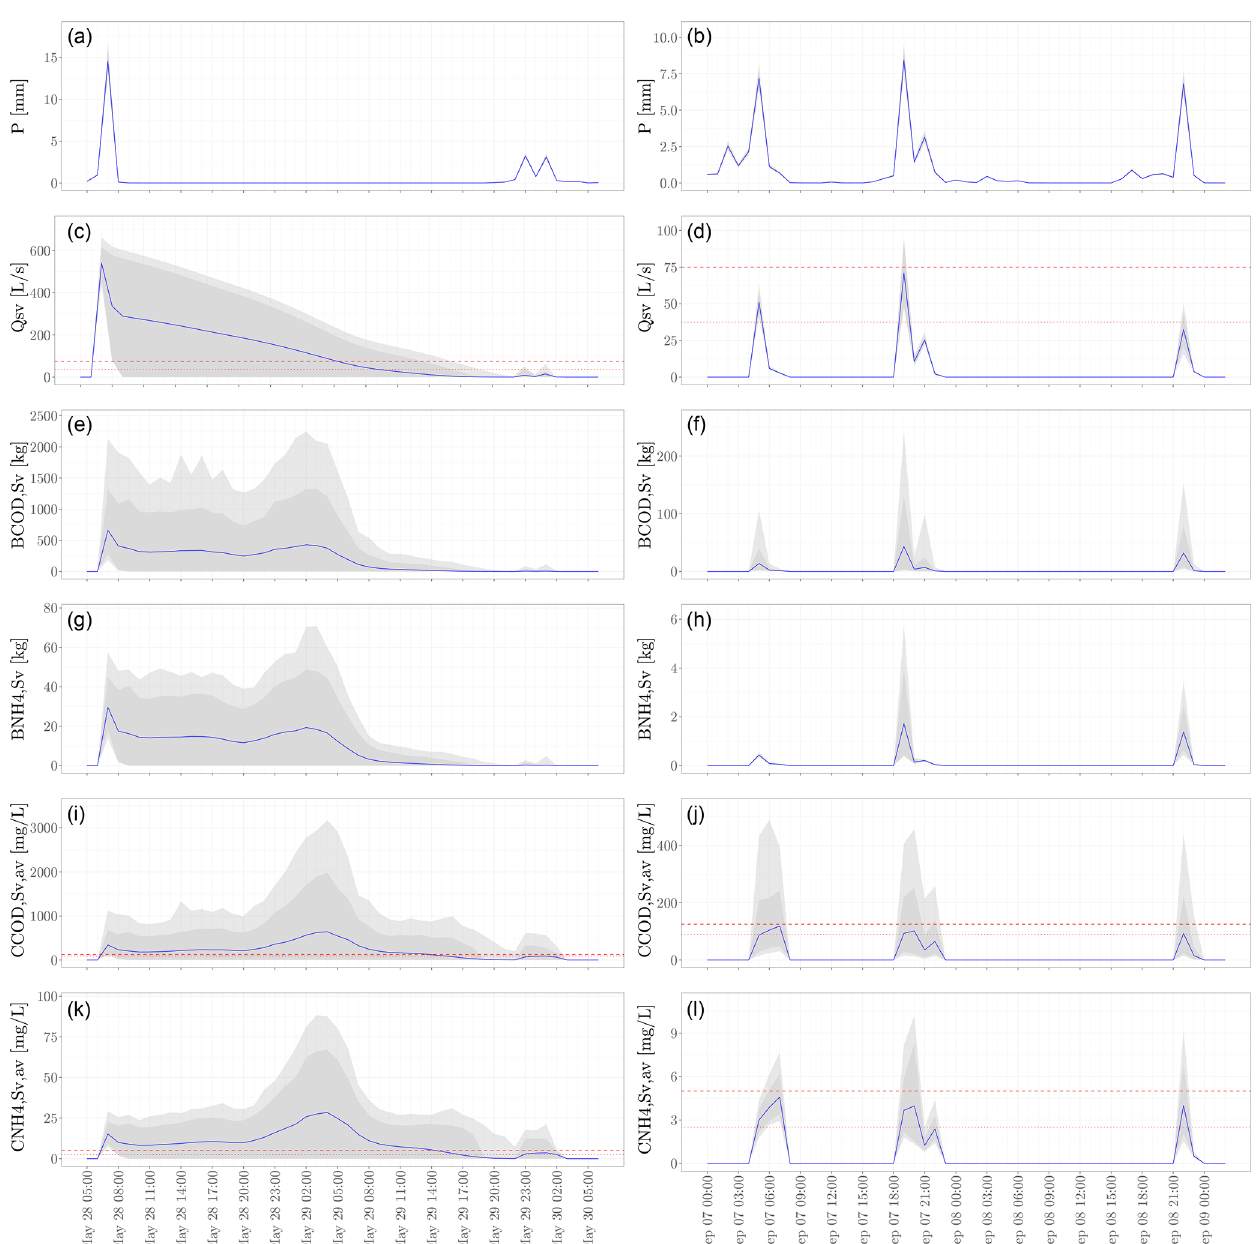
Figure 3. Uncertainty propagation outcomes for the first Monte Carlo simulation, where all input variables vary stochastically. The 99% prediction interval is shown as a light grey shading, the 90% prediction interval as a dark grey shading, and the mean value as a blue line. The MC simulations were performed for the entire year of 2010 at a 10min time step, aggregated to hourly time steps in the figure. (a, b) Input precipitation. (c, d) In the overflow spill flow, the upper dashed red line indicates the 75Ls − 1 threshold and the lower dotted red line the 37.5Ls − 1 threshold. (e, f) Load of overflow COD. (g, h) Load of overflow NH 4 . (i, j) In the average spill COD concentration, the upper dashed red line indicates the 125mgL − 1 threshold, and the lower dotted red line indicates the 90mgL − 1 threshold. (k, l) In the average spill NH 4 concentration, the upper dashed red line indicates the 5.0mgL − 1 threshold and lower dotted red line the 2.5mgL − 1